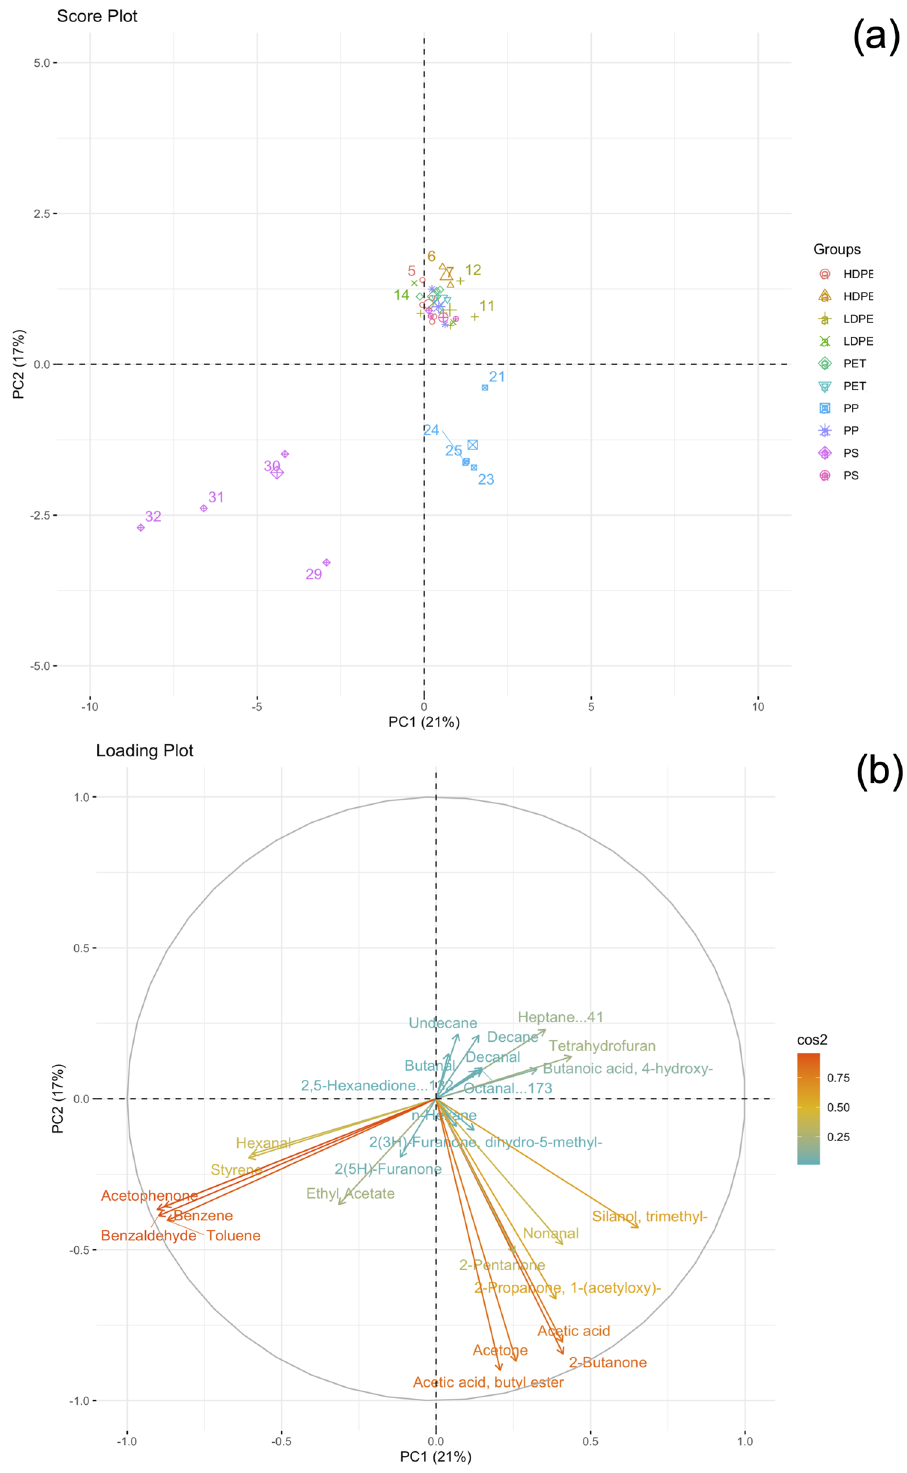
Figure 2. Principal component analysis of HiSorb-GC-MS data: ( a ) score plot and ( b ) loading plot.